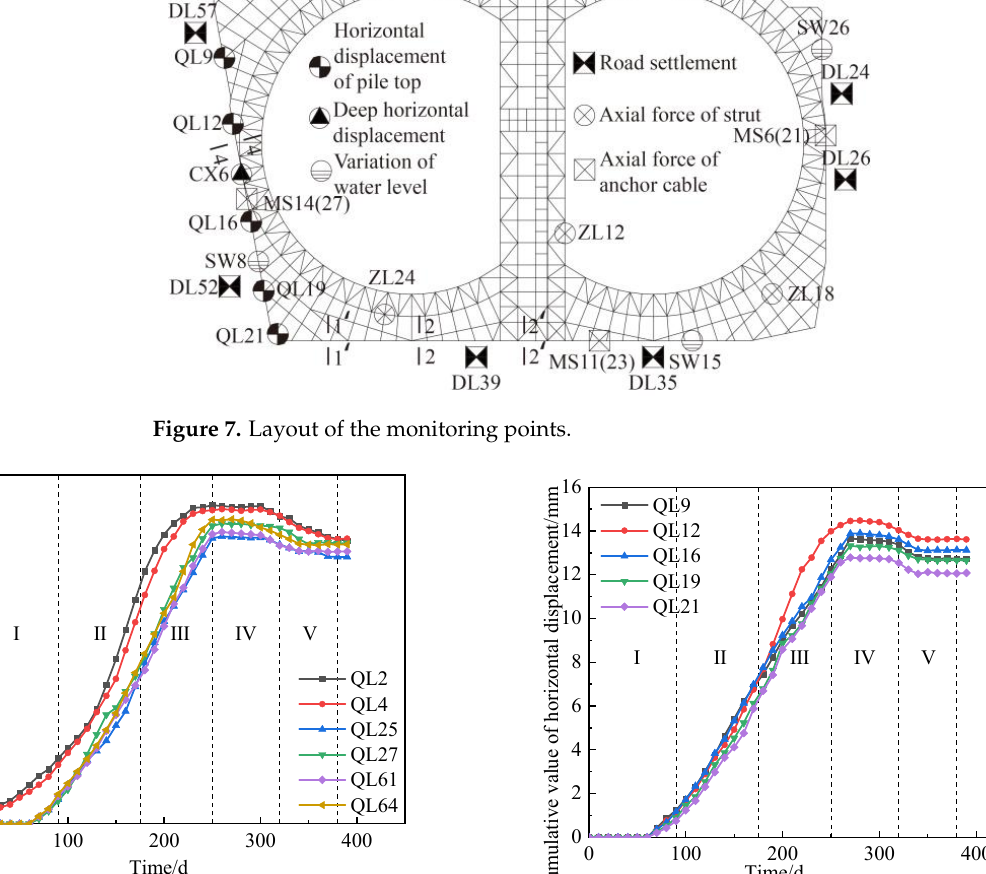
Figure 7. Layout of the monitoring points.